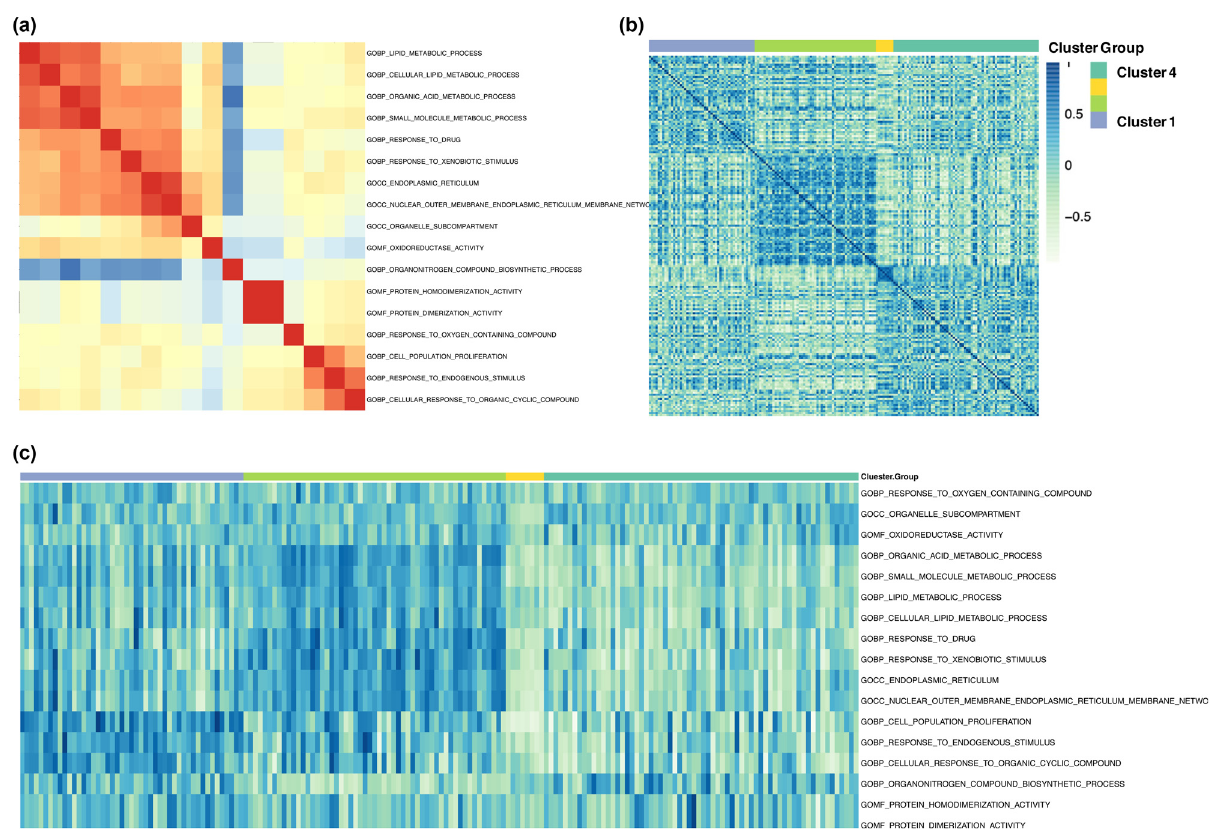
Figure 4: Gene set variation analysis: ( a ) the linkage - heatmap describes the existence of linkage correlation modules between the GSVA scores of the GO pathway; ( b ) the linkage - heatmap describes the correlation modules that are linked between the GSVA scores within di ff erent subtypes of TCGA; ( c ) signi fi cant di ff erences in GO pathways ( P value < 0.05 ) in the heatmap can see obvious strati fi cation in the four